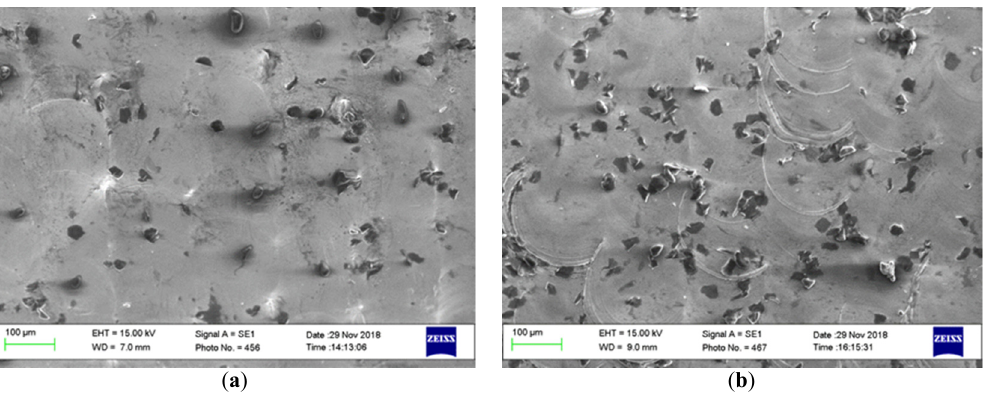
Figure 15. SEM micrograph showing the martensitic islands on the top view of samples processed with 110 W, beam focused on surface, and ( a ) 50 rpm and ( b ) 80 rpm.